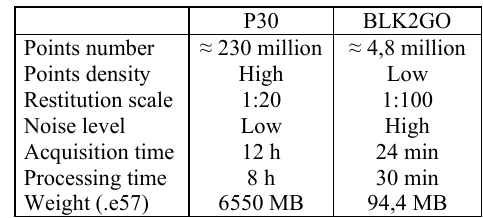
Table 1 . Comparison between P30 and BLK2GO point